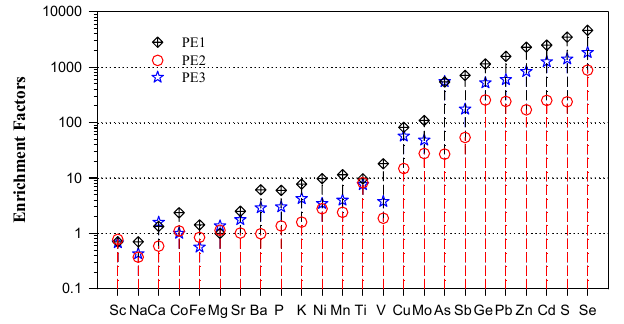
Fig. 7. The average enrichment factors (EF) of various elements during PE1, PE2, and PE3, respectively.